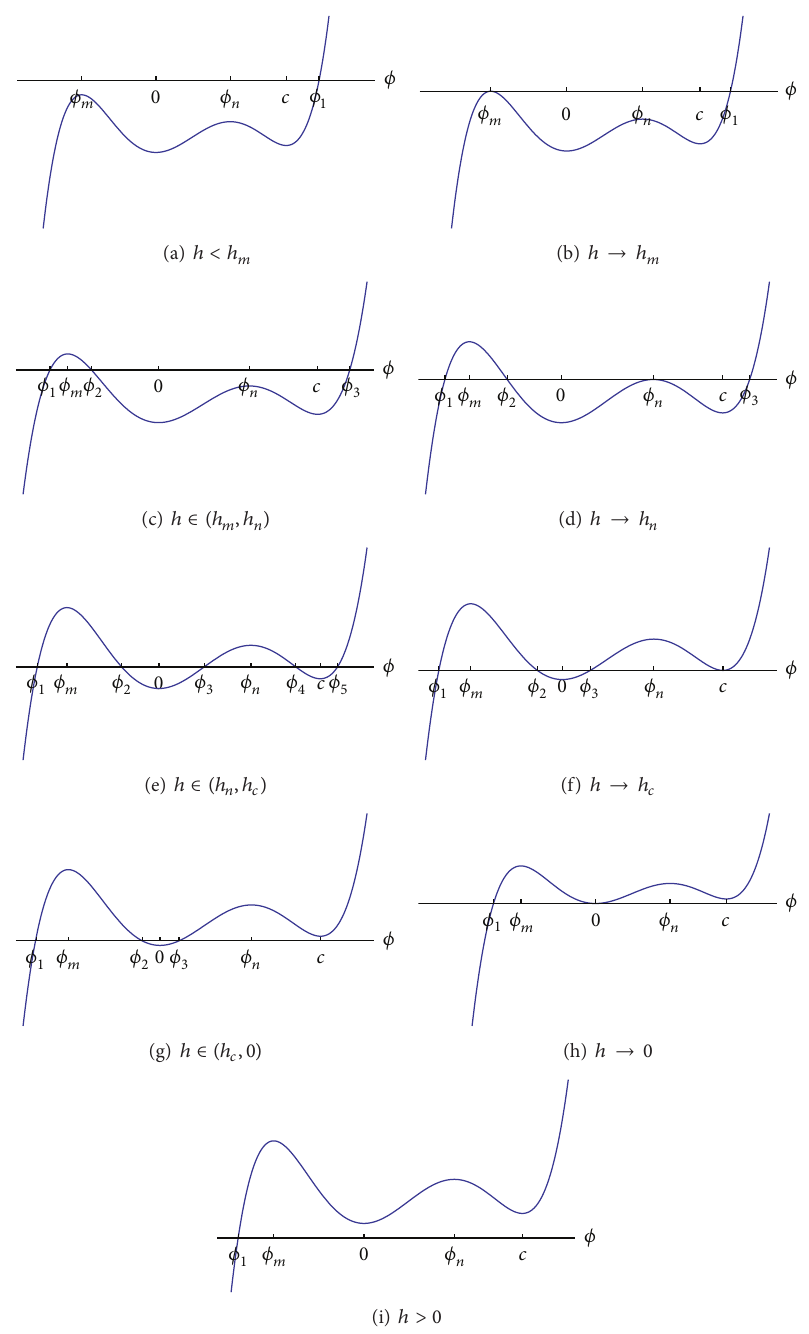
Figure 6: The graph of 𝐹(𝜙) as (1/3)(3𝑐 − 4𝑐 2 ) < 𝑐 0 < (1/5)(5𝑐 − 2𝑐 2 )